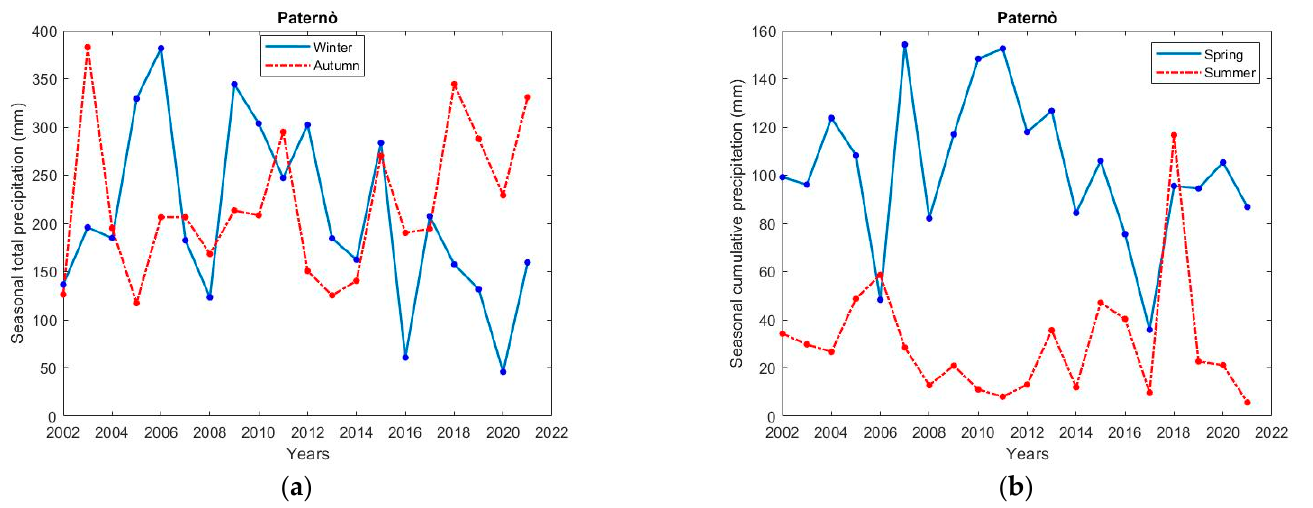
Figure 4. Seasonal cumulative precipitation trends: ( a ) in winter and autumn, ( b ) in spring and summer, for the Paternò case study.